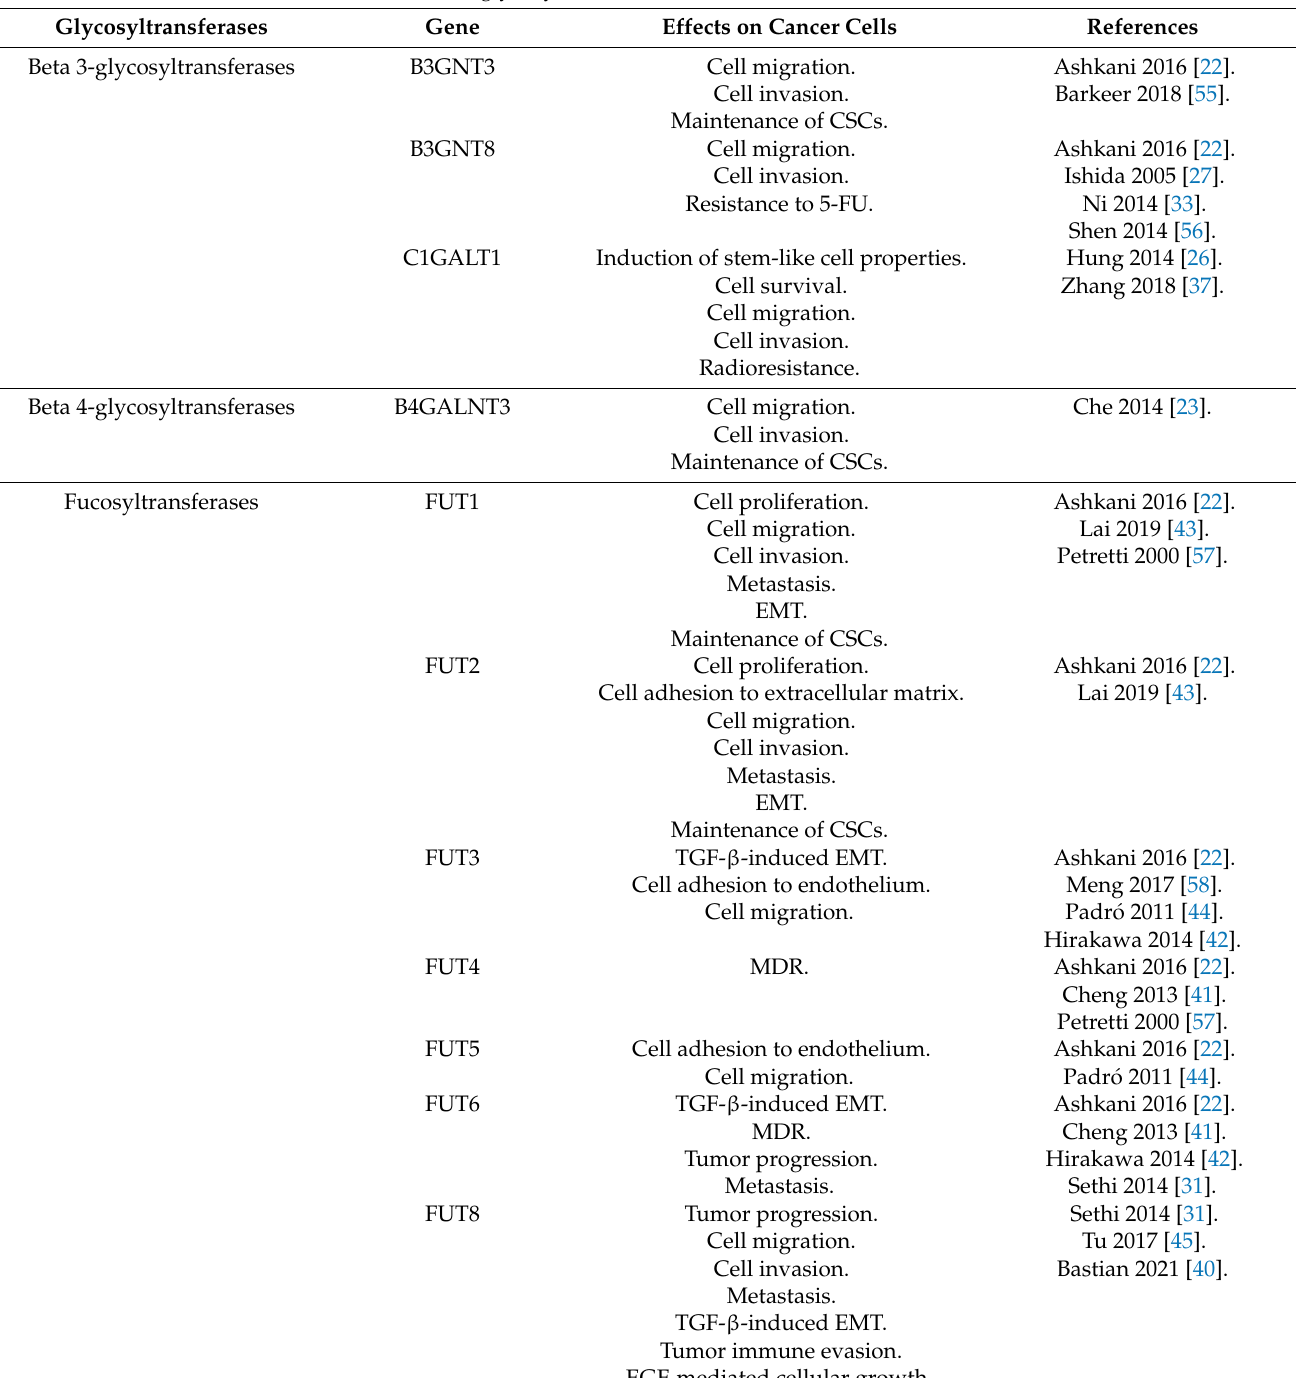
Table 1. Upregulated and downregulated glycosyltransferase genes in CRC. A. Upregulated glycosyltransferase genes in CRC . Cellular effects induced by the upregulation of genes encoding glycosyltransferases are